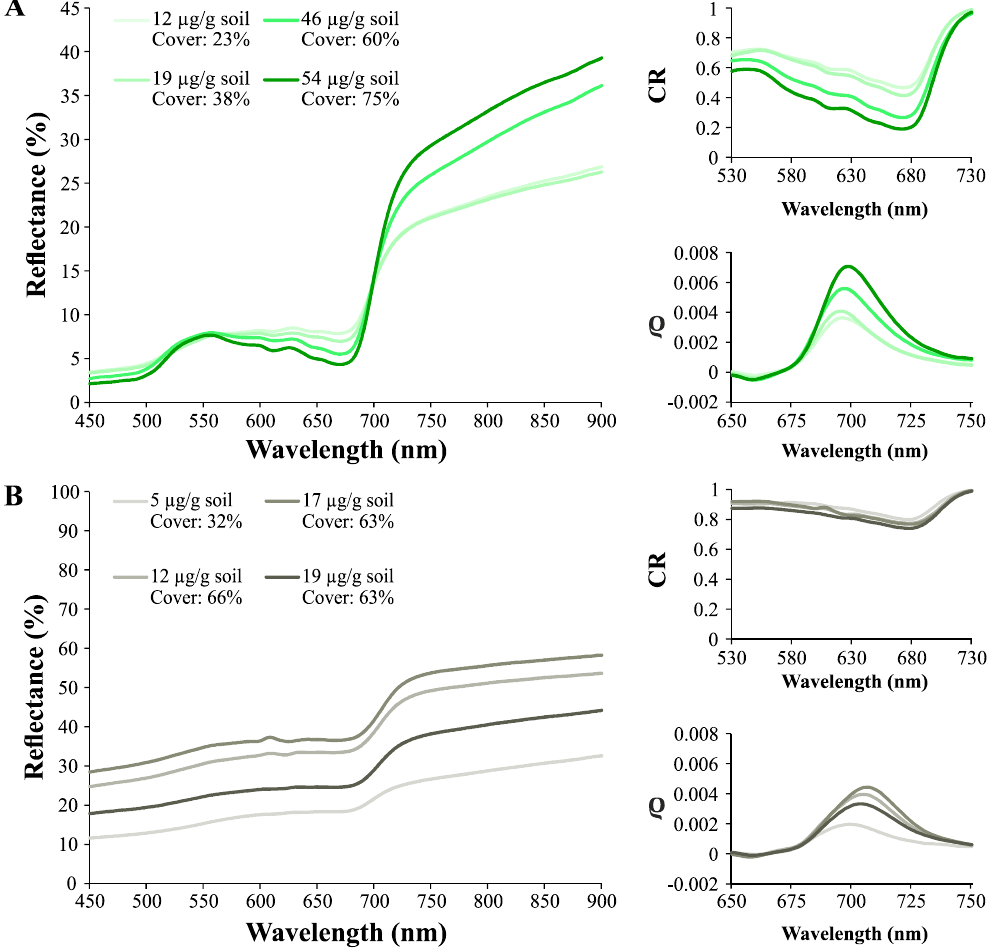
Figure 4. Reflectance, continuum removal (CR), and first derivate of reflectance ( ρ ) for selected samples of ( A ) moss- and ( B ) lichen-dominated crust with different cover and Chl a concentration from the Las Amoladeras study site.